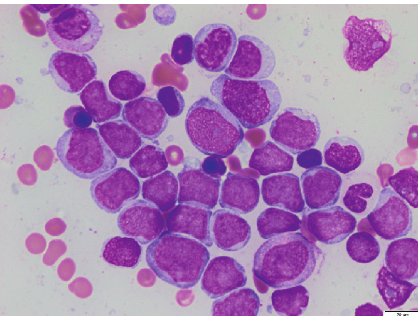
Figure 2: Bone marrow aspirate smears were significant for approximately 62% myeloblasts, and the background hematopoiesis was markedly